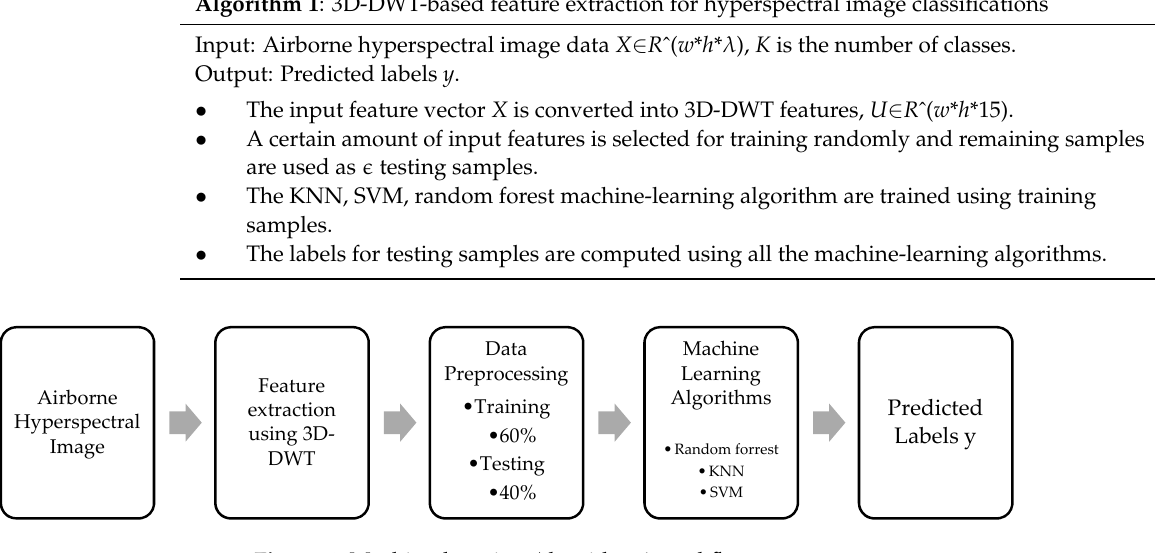
Figure 4. Machine-learning Algorithm 1 workflow. Algorithm 1 : 3D-DWT-based feature extraction for hyperspectral image classifications